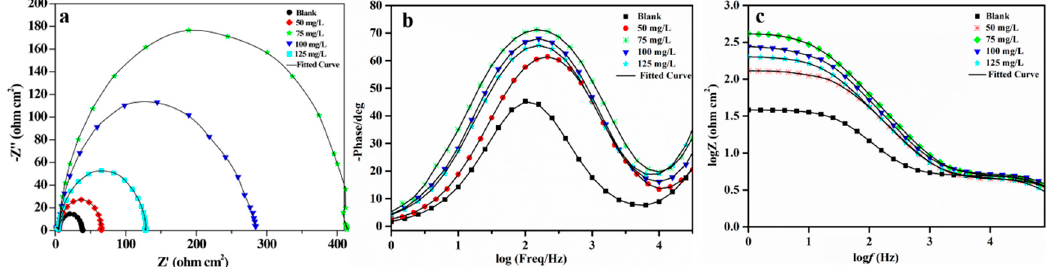
Figure 5. ( a ) Nyquist plots, ( b ) bode plots and phase angle plots ( c ) of steel in an HCl solution containing different inhibitor concentrations.